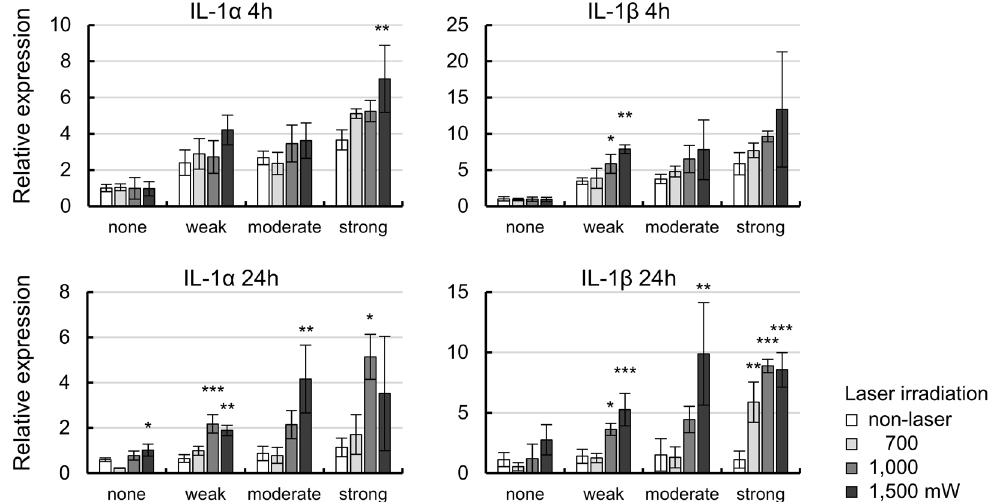
Figure 3. Expression levels of IL-1α/β after 4 or 24 h of MP-laser irradiation of cells with each pigmentation intensity. mRNA levels of IL-1α/β were measured by qPCR (n = 3). Data are represented as mean ± standard deviation of the mean. * P < 0.05, ** P < 0.01, *** P < 0.001 by Dunnet’s multiple comparisons